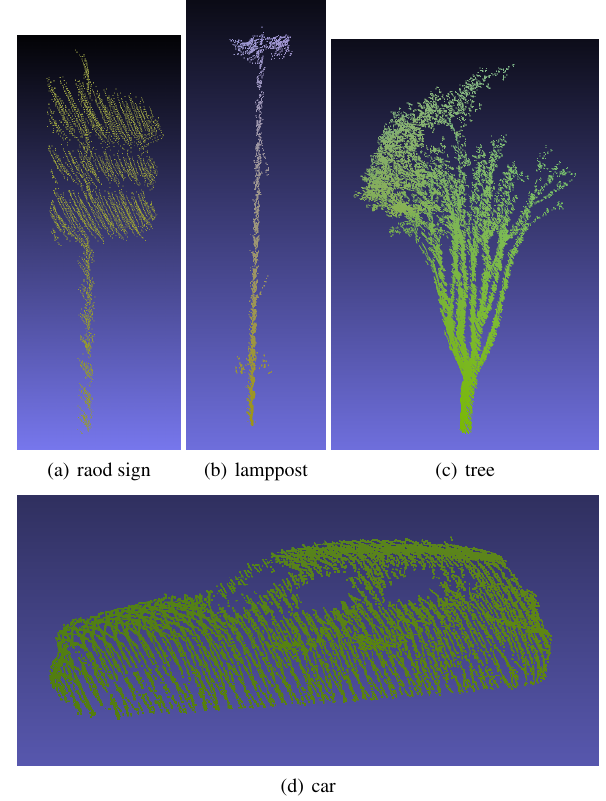
Figure 3: Exemple of sub-clouds well segmented after ground extraction